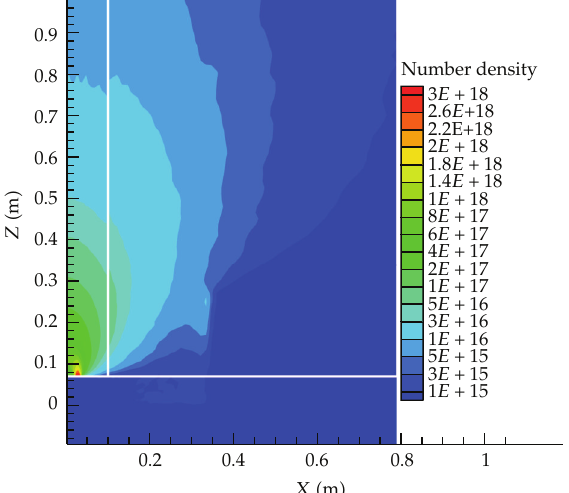
Figure 5: Contours of number density for slice through surface 1.